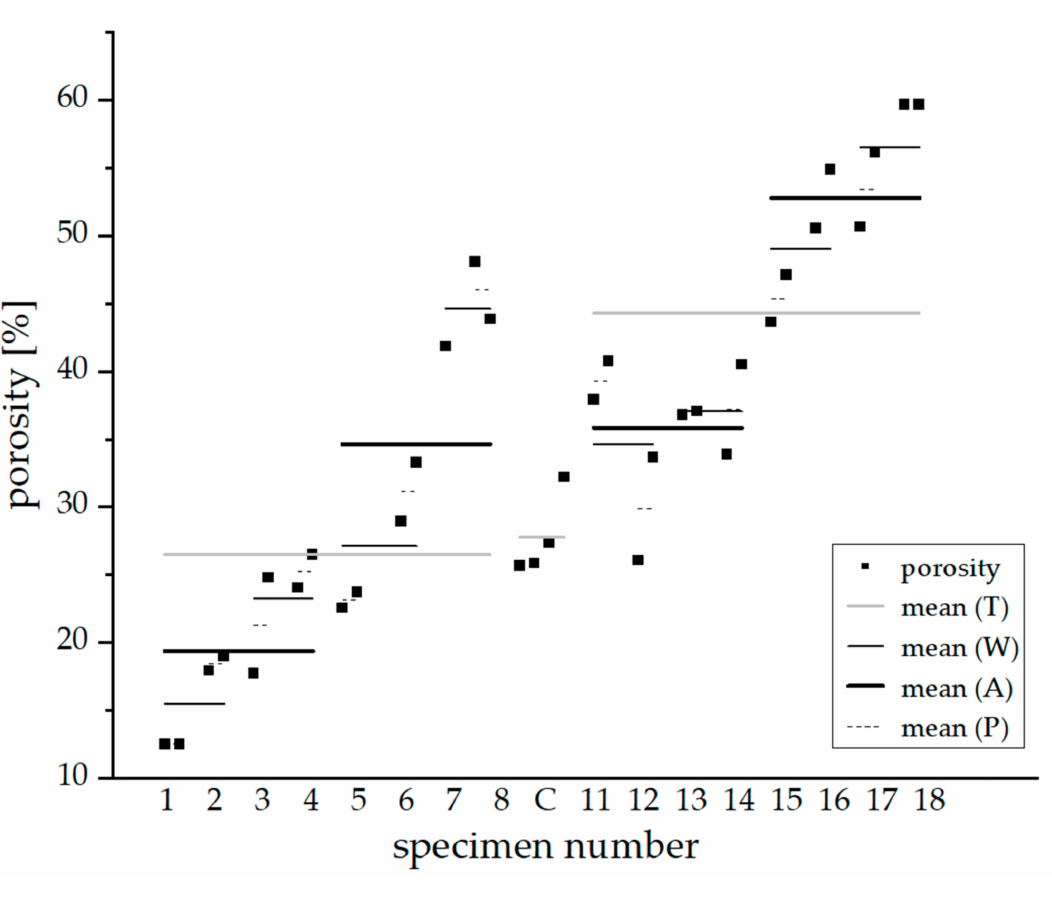
Figure 4. Porosity of the samples of DoE.